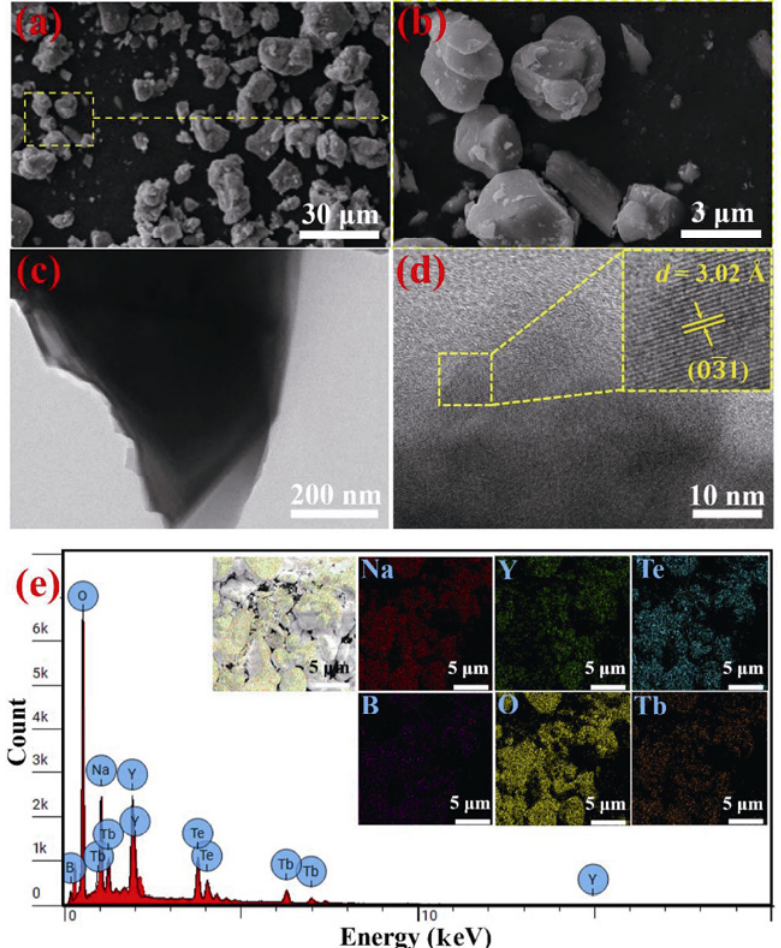
Fig. 2 (a, b) SEM images. (c) TEM image. (d) HRTEM image. (e) Energy-dispersive X-ray spectroscopy (EDS) data for NYTB:70%Tb 3+ (the inset shows elemental